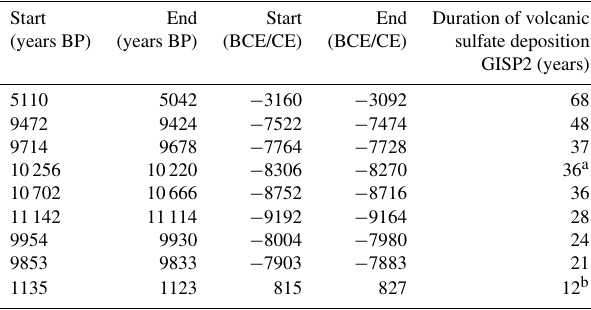
Table 3. Prolonged eruptions. All volcanic sulfate deposition sig- nals lasting > 20 years sorted by duration as well as the most re- cent signal persisting > 10 years from the GISP2 on the WD2014 timescale. Start and end dates are shown in the before present (1950 CE) notation as well as in the Common Era (CE) and Before the Common Era (BCE) notation using the ISO 8601 standard, which includes a year